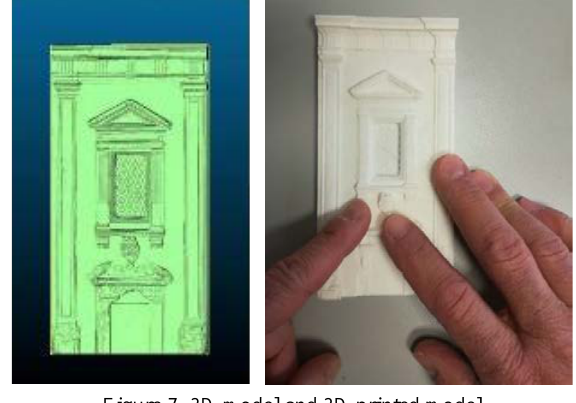
Figure 7. 3D model and 3D printed model